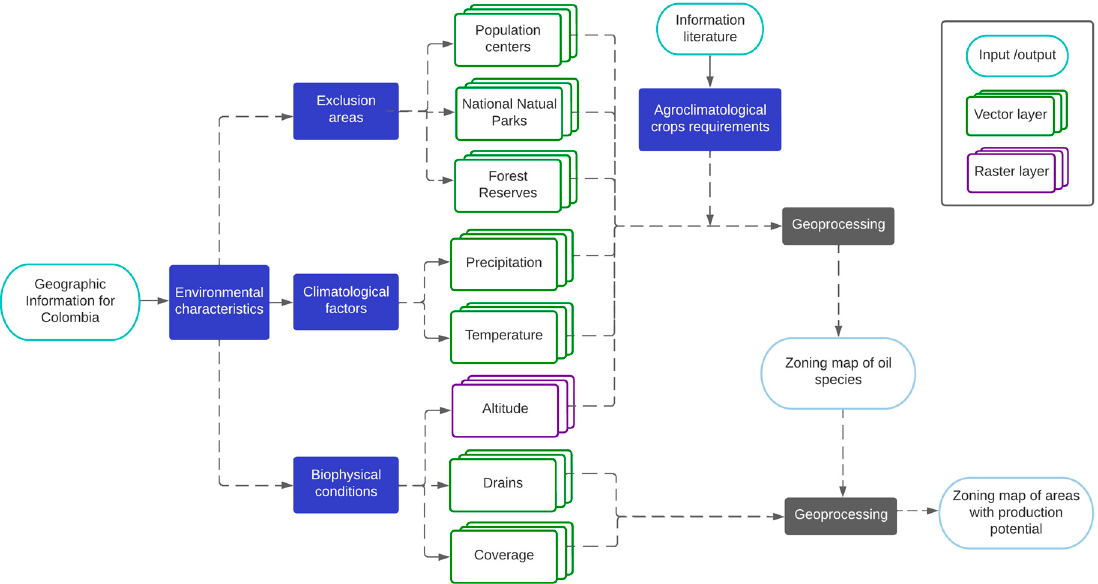
Figure 1. Geoprocessing model for potential zoning of oleaginous under agroforestry systems in Colombia. in